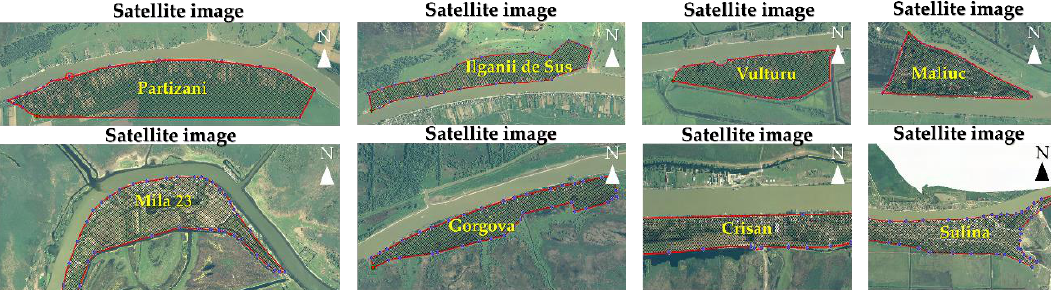
Figure 10. The boundary representation of the flow surface for each settlements: Partizani, Ilganii de Sus, Vulturu, Maliuc, Mila 23, Gorgova, Crișanand Sulina.